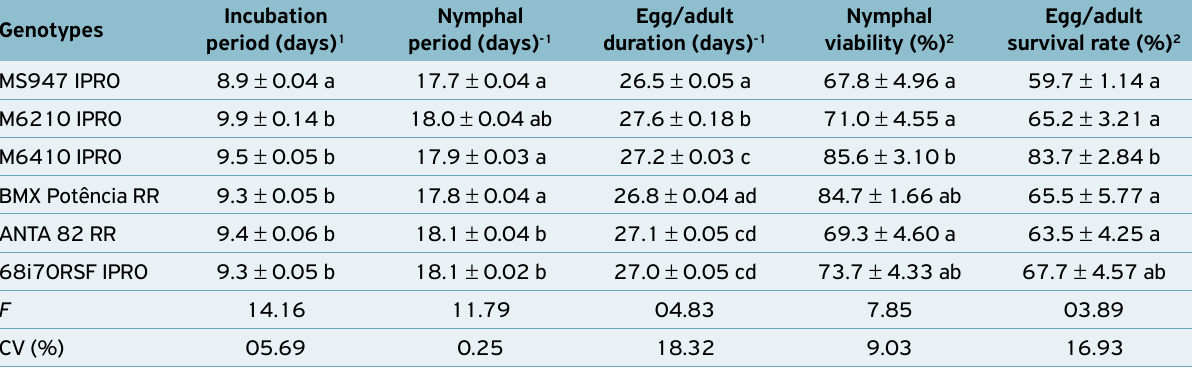
Means followed by same uppercase letters (within columns) and lowercase letters (within lines) are not significantly different based on the non-parametric Kruskal-Wallis post-hoc test — Bonferroni correction; t-Student: 3.405883; alpha: 0.05; least-significance difference — LSD: 61.16035; SE: standard error. Table 4. Mean incubation period, nymphal period, egg-to-adult duration, nymphal viability, and egg-to-adult survival rate (mean ± standard error) of Bemisia tabaci B biotype obtained in six soybean genotypes under greenhouse conditions, Dourados (MS), Brazil, 2016.